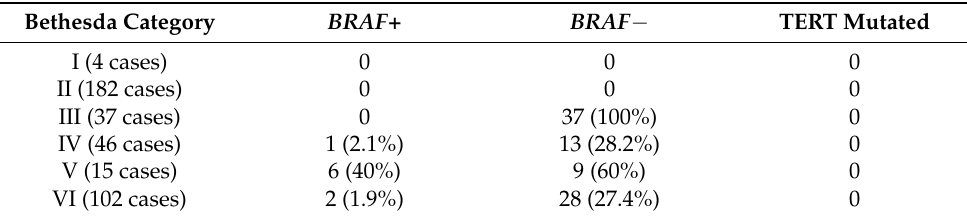
Table 10. Molecular testing for BRAF V600E and TERT promoter mutations in larger nodules. Bethesda Category BRAF + BRAF